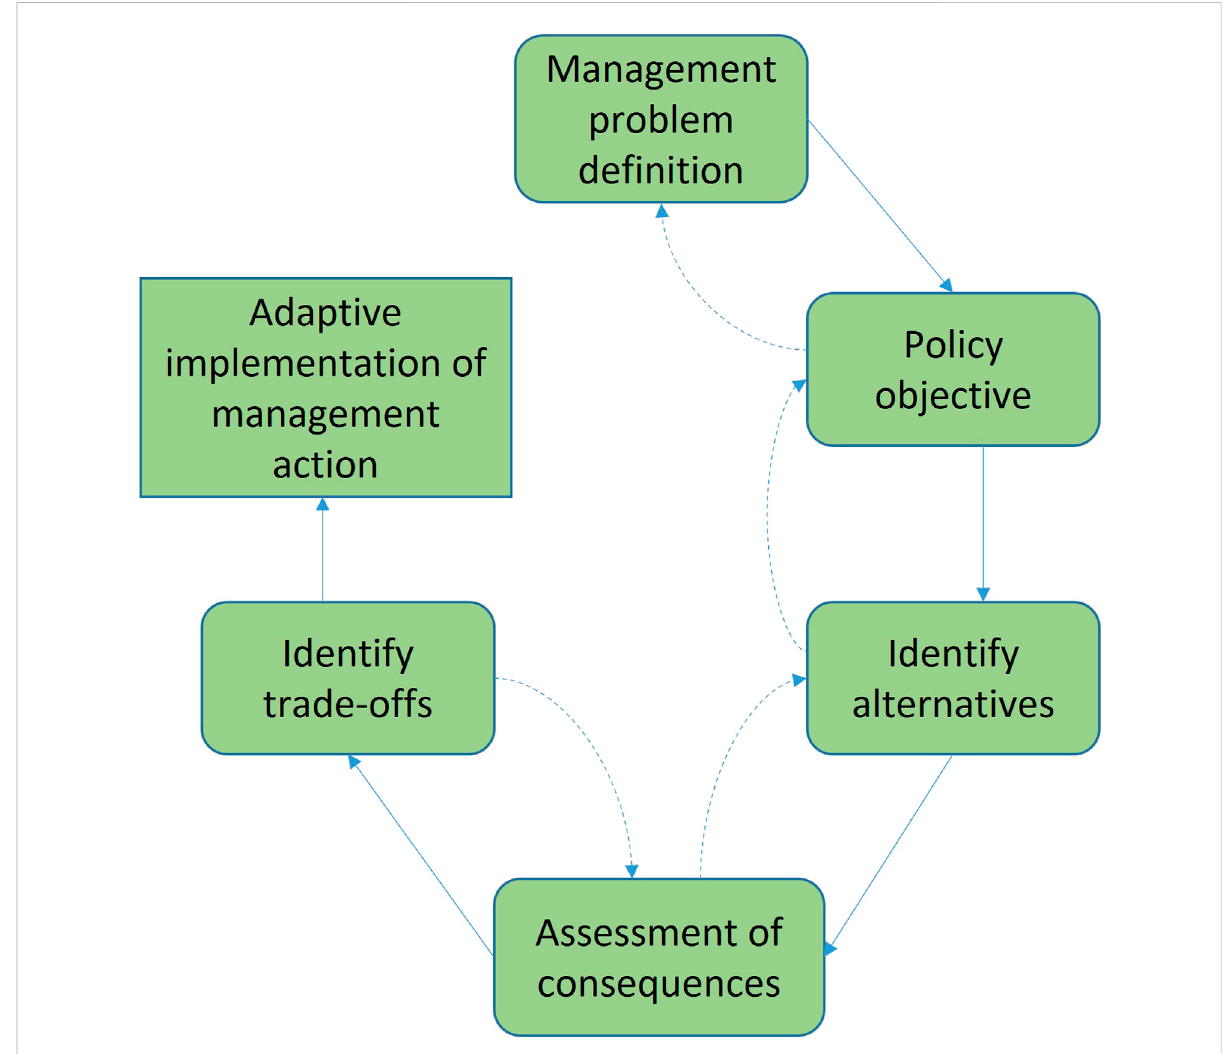
FIGURE 1 Elements in the structured decision-making: The PrOACT (Problem statement, Objectives, Alternatives, Consequences and Trade-offs) sequence (Runge et al., 2020). The dashed lines indicate the element of a decision is not necessarily